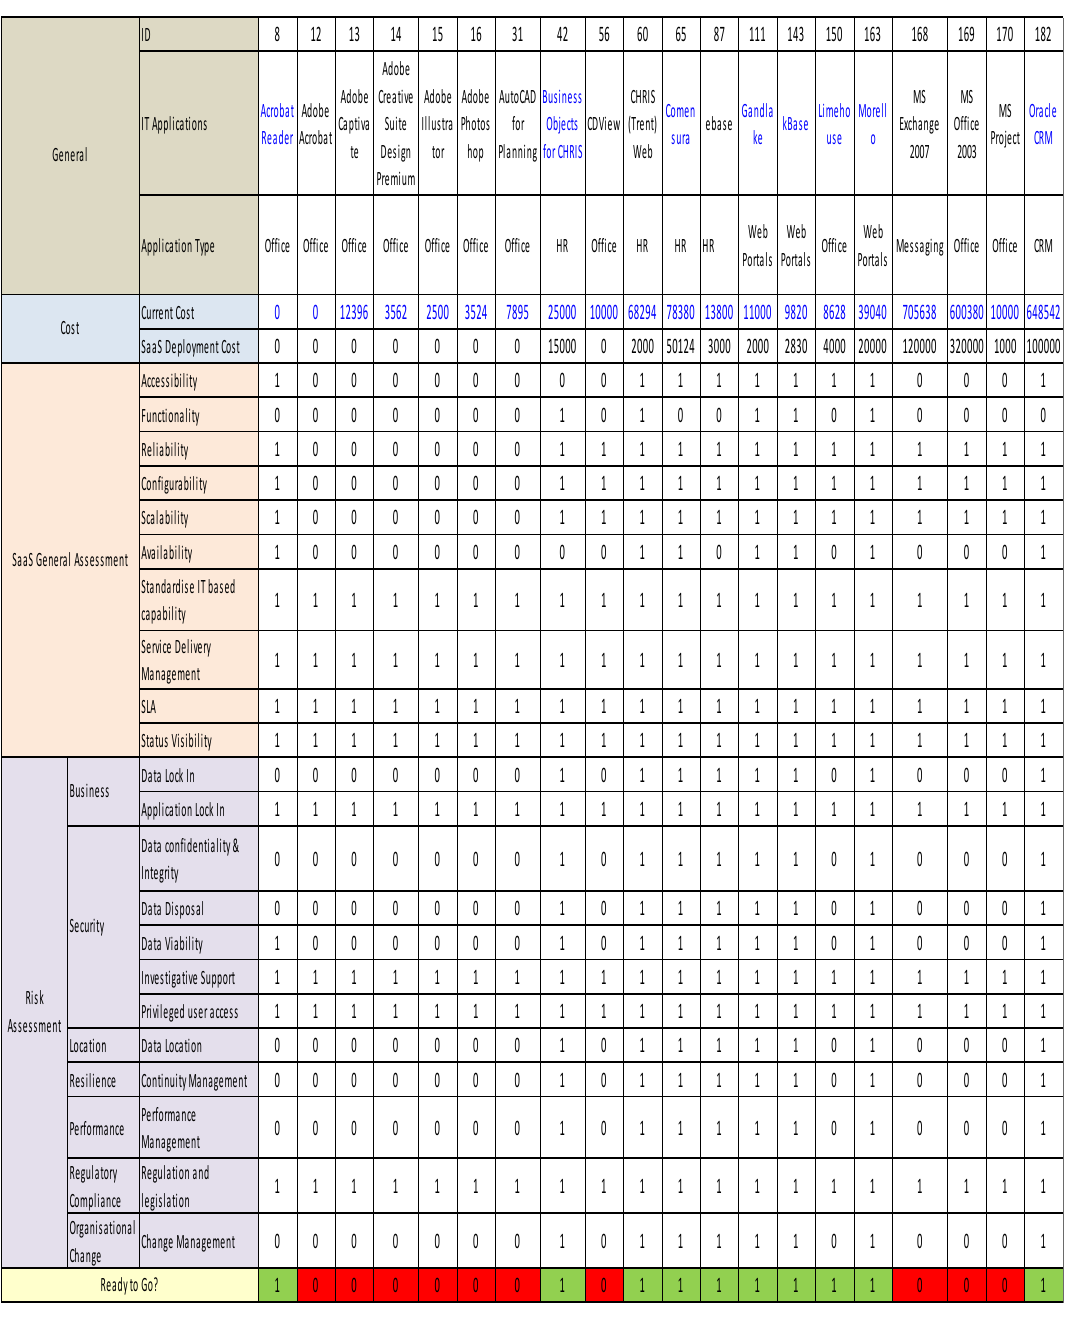
Figure 6. The SaaS assessment